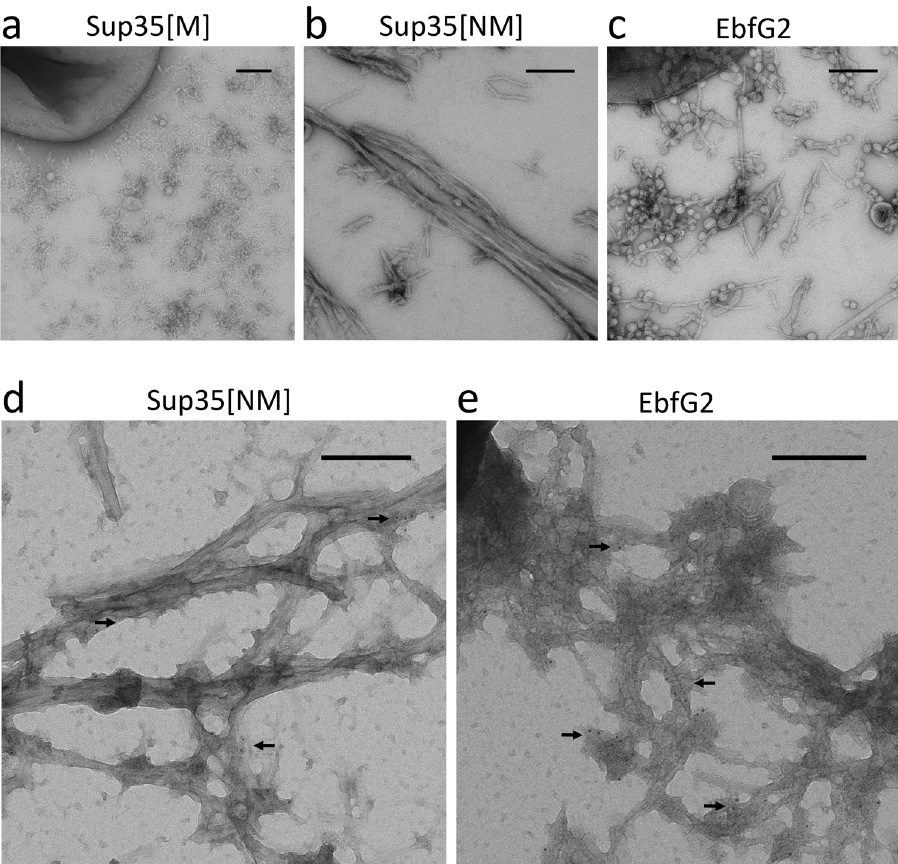
Fig. 7 Transmission electron microscopy (negative staining) images of EbfG2 expressed in the C-DAG system. a Negative control (Sup35[M]) b Positive control (Sup35[NM]) c EbfG2 expressed in the C-DAG system. Fibril-like structures are found in the extracellular space for the positive control (Sup35[NM]) and EbfG2. d , e Immunogold stained samples where 6 nm gold marker particles localize to the fi bril-like structures of the positive control ( d ) and EbfG2 ( e ). Arrows indicate gold particles. The scale bars correspond to 200